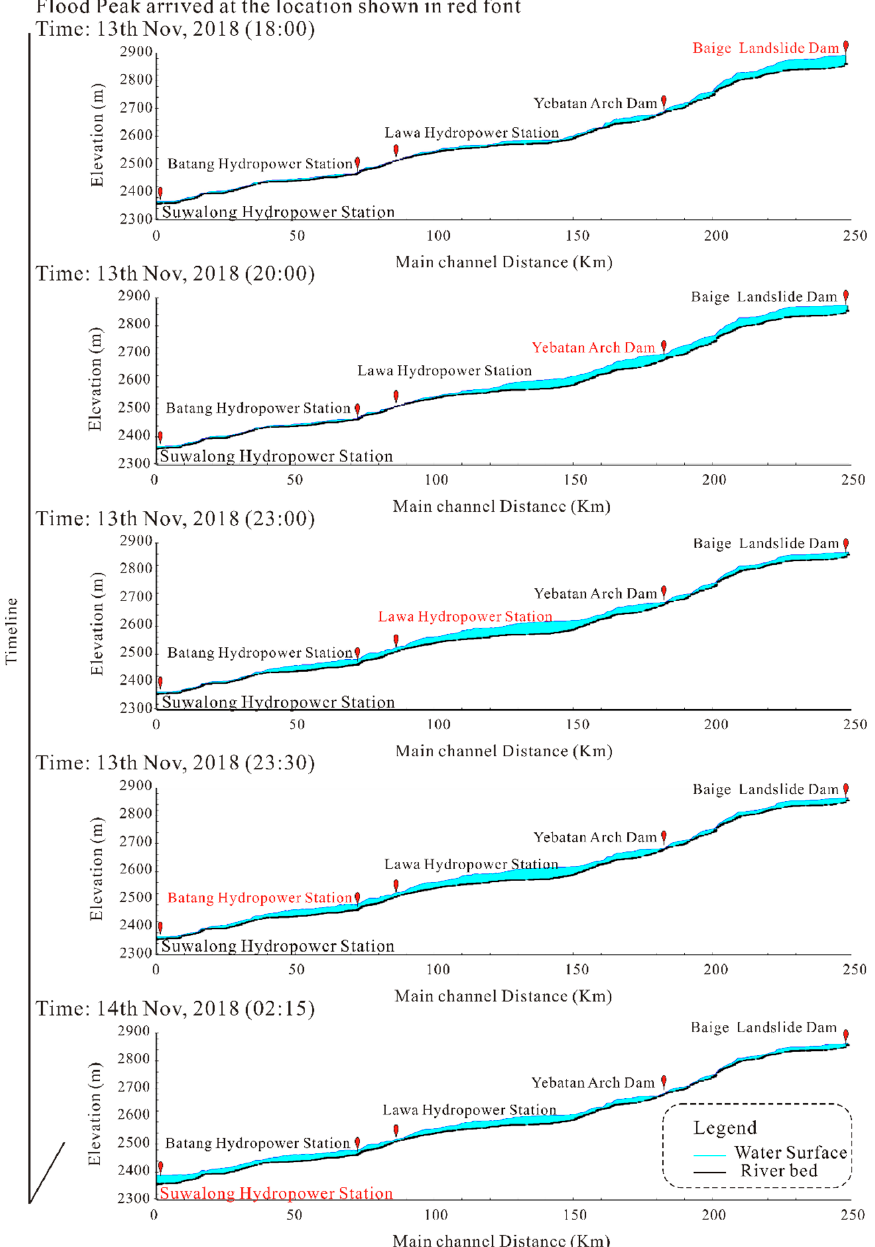
Figure 6. Water surface curves of the flood process in natural discharge (flood peak arrived at the location shown in red font).